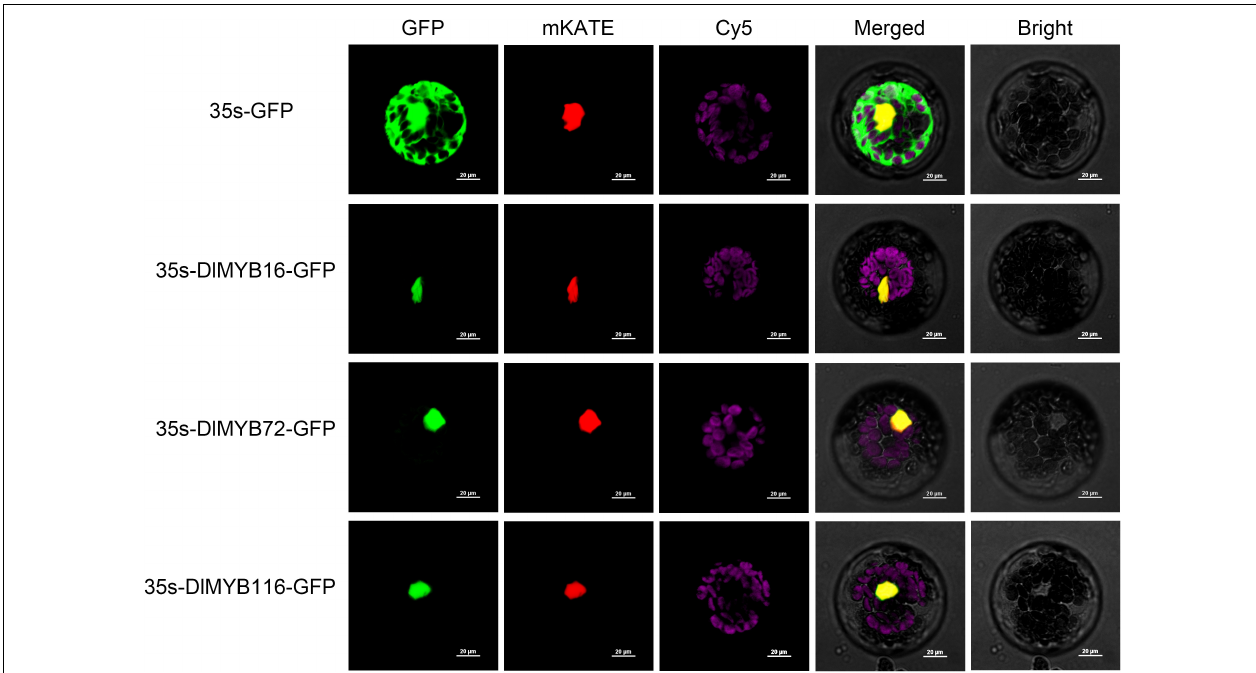
FIGURE 6 | Nuclear localization of DlMYB16, DlMYB72, and DlMYB116 proteins in Arabidopsis protoplasts. GFP: green fluorescent protein; mKATE: nuclear marker; Cy5: chloroplast; Bright: bright field; merged: combined mKATE and GFP and bright field. Bars, 20 µ